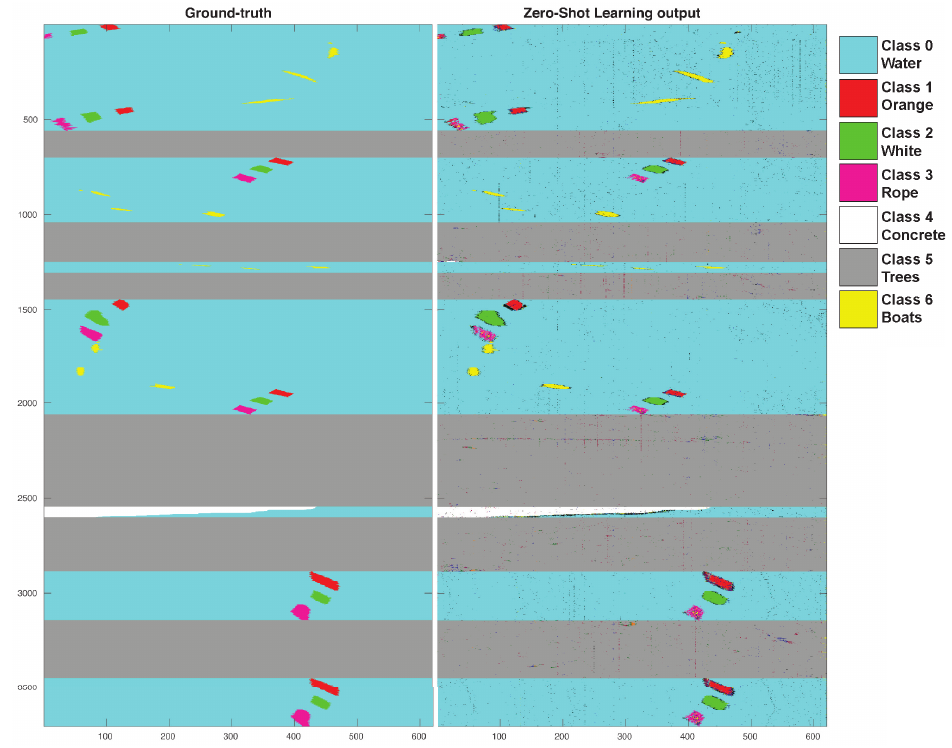
Figure 8. Left image holds the ground truth while the right image shows the zero-shot learning